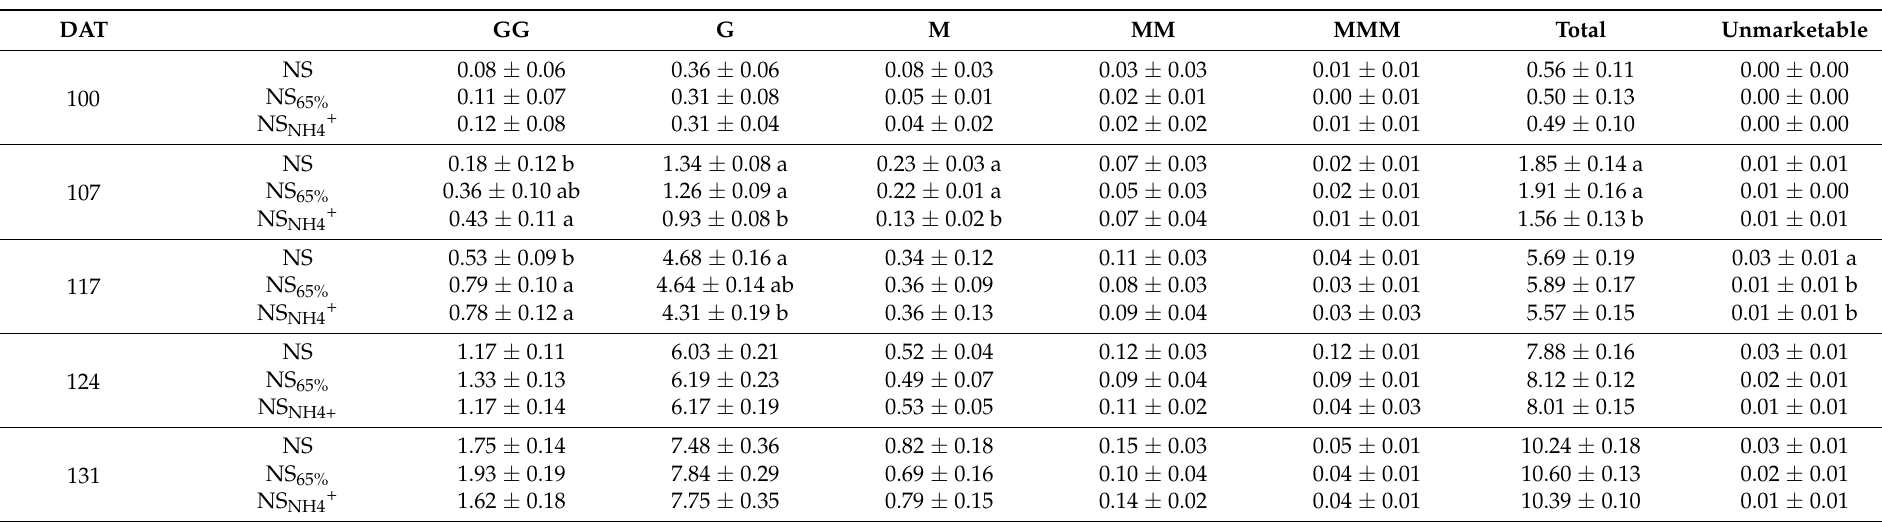
Table 2. Accumulated marketable yield by categories (kg m − 2 ) and unmarketable fruits (kg m − 2 ) at different dates of yield period. The treatments were: (i) conventional fertigation (NS); (ii) 65 % of the fertilizers applied in conventional fertigation (NS 65% ); and (iii) with 20% of the total N applied in conventional fertigation being NH 4+ (NS NH4+ ). Unmarketable means a fruit diameter less than 40 mm, MMM between 40–46 mm, MM 47–56 mm, M 57–66 mm, G 67–80 mm, and GG over 81 mm. Data are the means ± standard deviation of the samples ( n = 120) at the end of the trial. Means with different letters indicate significant differences among treatments at the p < 0.05 level by LSD test. No letters mean no differences among